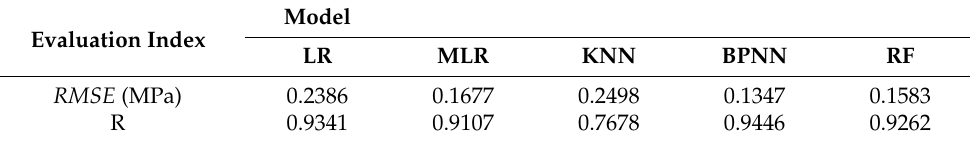
Table 4. Evaluation of 5 ML models on FS test group.